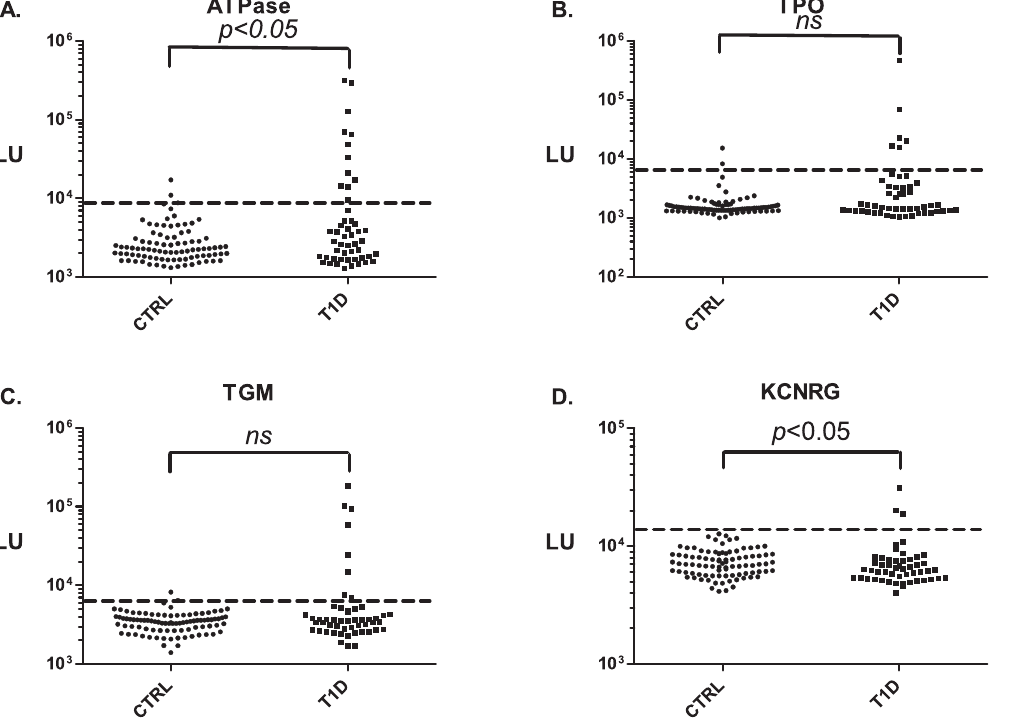
Figure 2. Profiling organ specific autoantibodies in a second cohort of T1D and control subjects. Autoantibodies were evaluated in the DASP 2010 samples containing 50 T1D patients and 90 controls. The autoantibody titers for ( A ) ATP4B, ( B ) TPO, ( C ) TGM, and ( D ) KCNRG, are plotted on the Y-axis using a log 10 scale. Each symbol in the scatterplots represents serum from one subject. The dashed line represents the cut-off level used for determining seropositivity and is derived from the mean plus 3 SD of the antibody titer of the 90